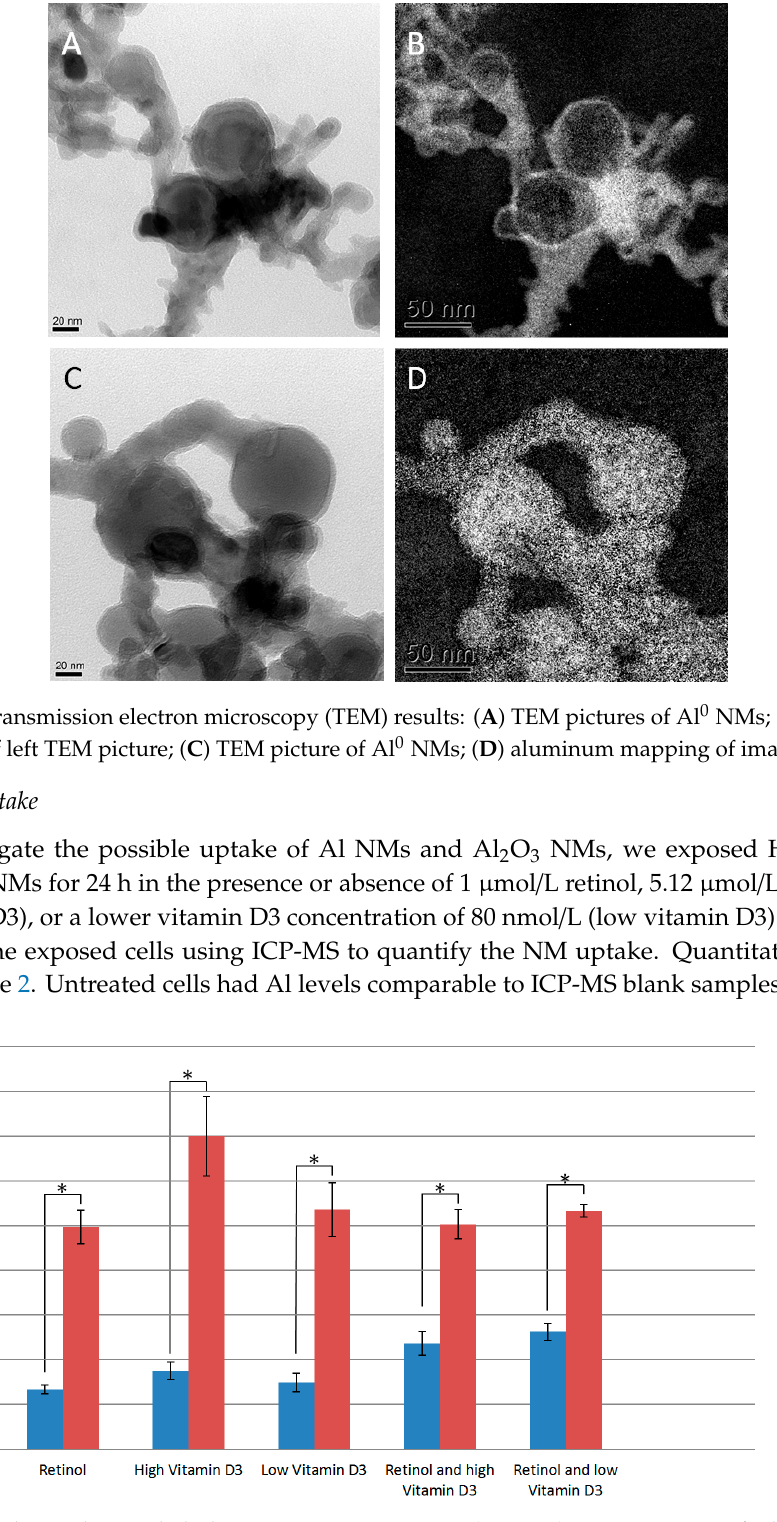
Figure 2. Inductively coupled plasma mass spectrometry (ICP-MS) measurements of Al content of HaCaT cells exposed to either Al 2 O 3 or Al 0 NMs as well as retinol and / vitamin D3. The cellular uptake is normalized to the Al uptake of cells exposed to Al 0 NMs or Al 2 O 3 NMs only. * p <